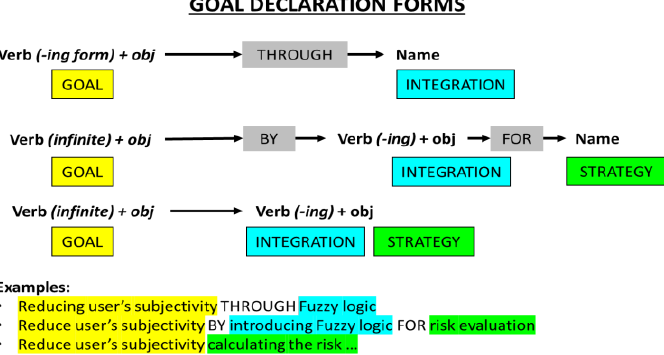
Figure 3. Common linguistic forms identified for declaring the goals of the proposed FMEA